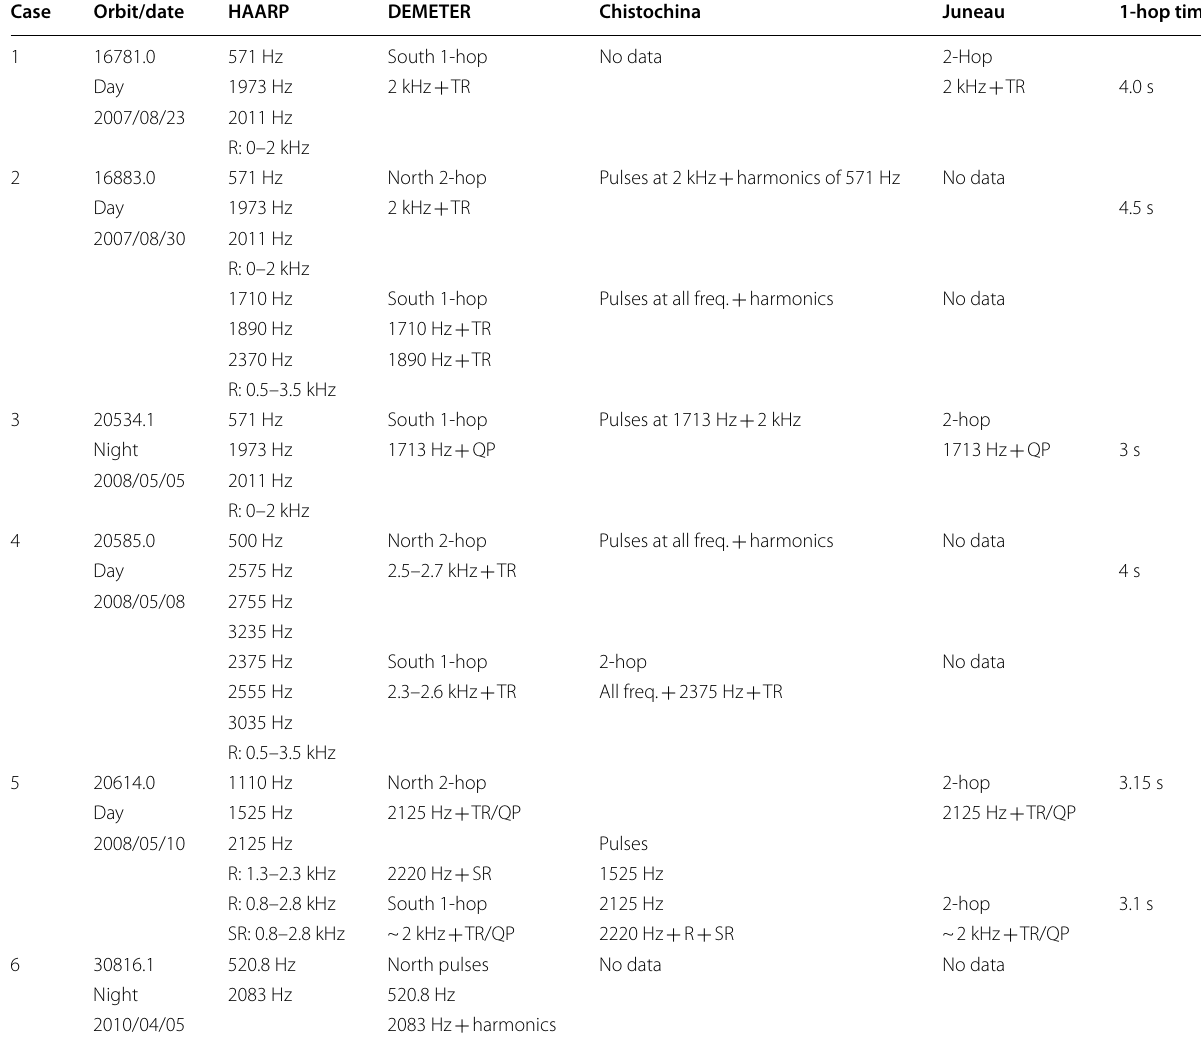
The frequencies of the pulses and the ramps (SR is for snake ramp) emitted by HAARP are indicated together with the frequencies of the pulses observed by DEMETER in the northern or in the southern hemisphere, and by the ground stations Chistochina and Juneau. TR is for triggered emissions and QP for quasi-periodic